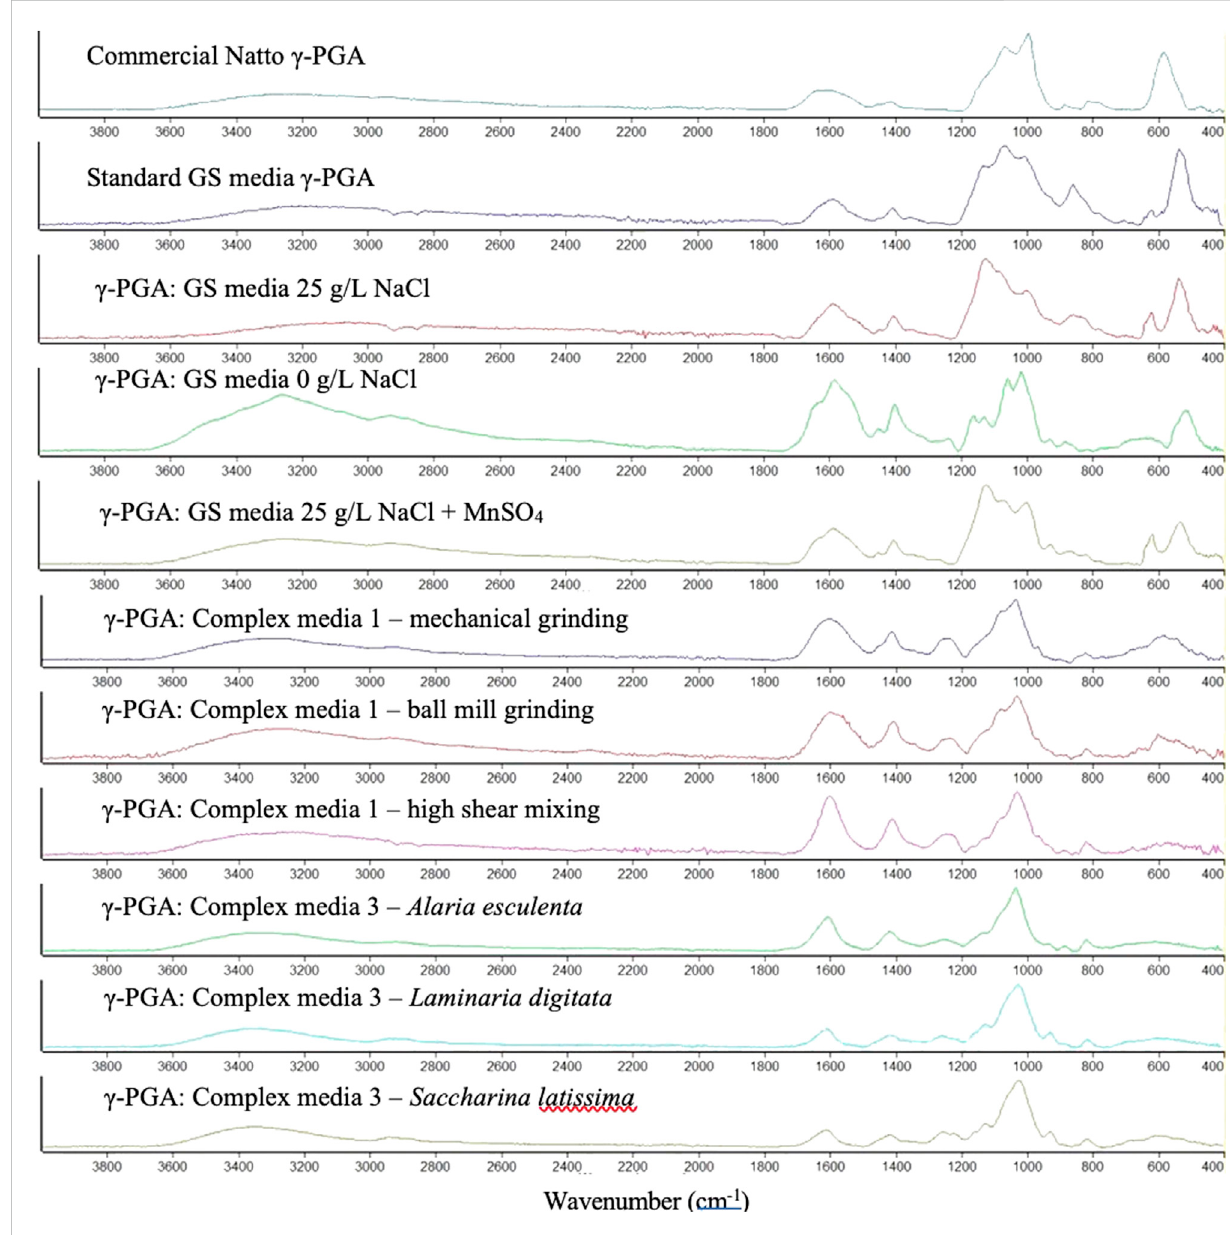
FIGURE 8 Absorbance Fourier Transform Infra-Red spectra of γ -PGA obtained from different standard and complex waste substrates after tangential fl ow fi ltration. The peaks within the fi gure represent different functional groups of γ -PGA: C=O stretch (1739 cm − 1 ), the Amide I N-H bend (1643 cm − 1 ), the Amide II stretch (1585 cm − 1 ), the C=O symmetric stretch of γ -PGA in its sodium (1402 cm − 1 ) or calcium (1412 cm − 1 ) isoform, the C-N stretch (1162 cm − 1 ), the N-H bending (689 cm − 1 ), the O-H stretch (3449 cm − 1